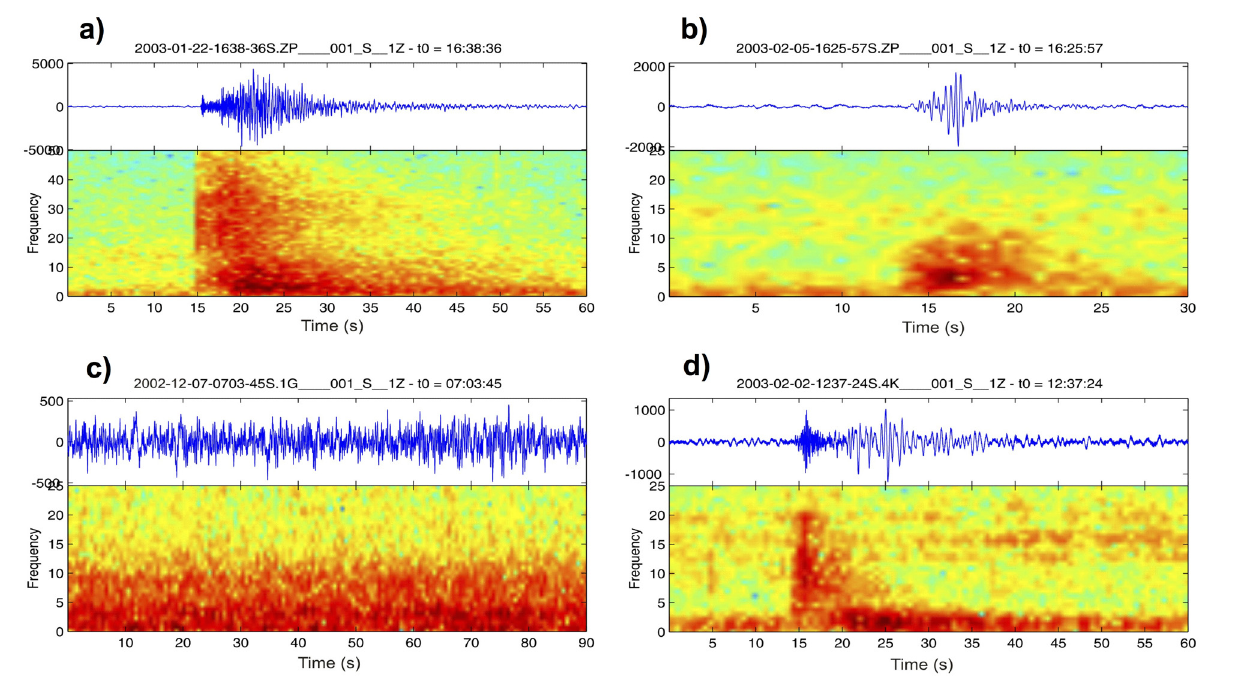
Figure 2. Examples of vertical-component seismograms and spectrograms recorded at Deception Island: (a) VT earthquake; (b) LP event with frequency content centered at 2.5 Hz; (c) volcanic tremor; (d) hybrid